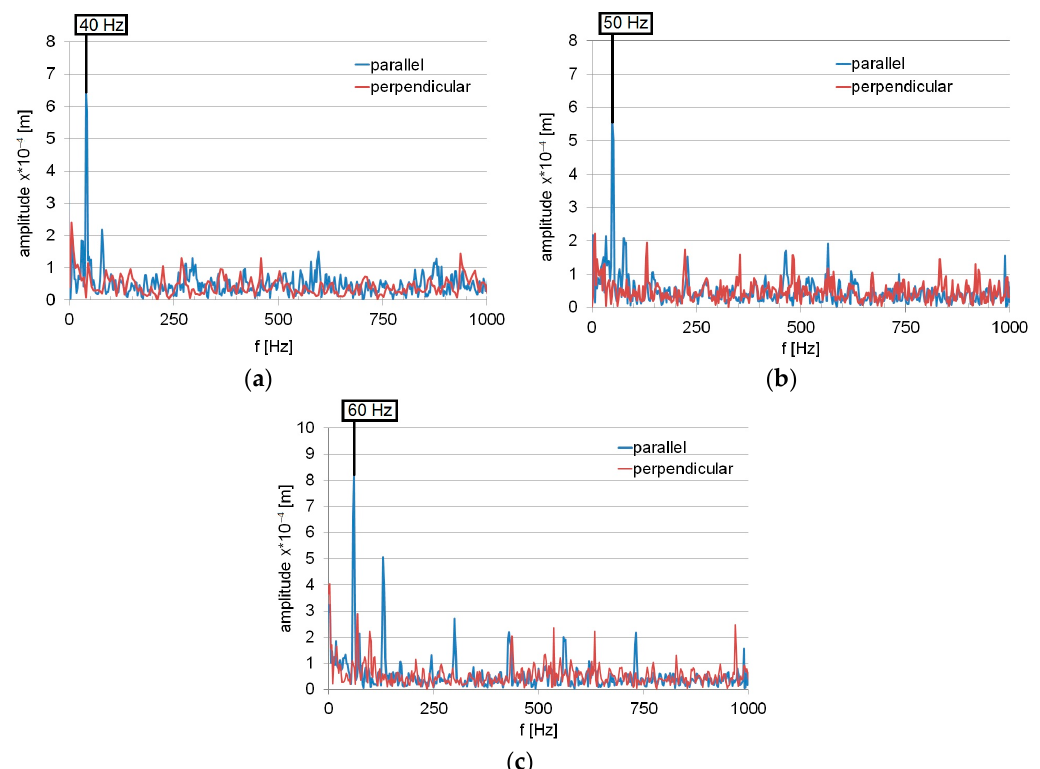
Figure 7. The amplitude-frequency spectrum of spool vibrations in the system with vibrating proportional directional valve: ( a ) vibration frequency of the simulator table 40 Hz; ( b ) vibration frequency of the simulator table 50 Hz; ( c ) vibration frequency of the simulator table 60 Hz.